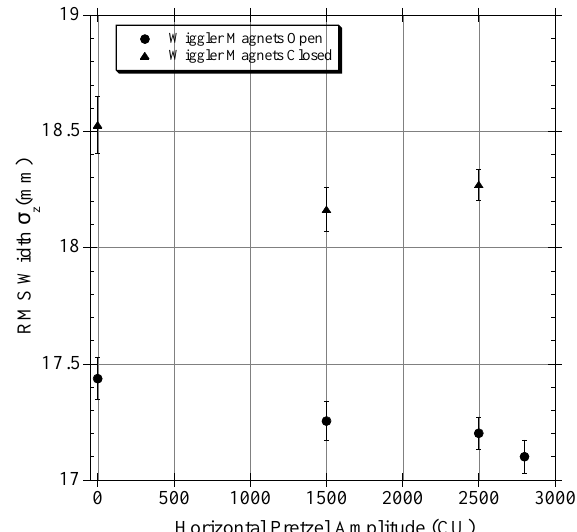
FIG. 12. The positron bunch length with the wiggler magnets open and closed as a function of the horizontal pretzel orbit amplitude.